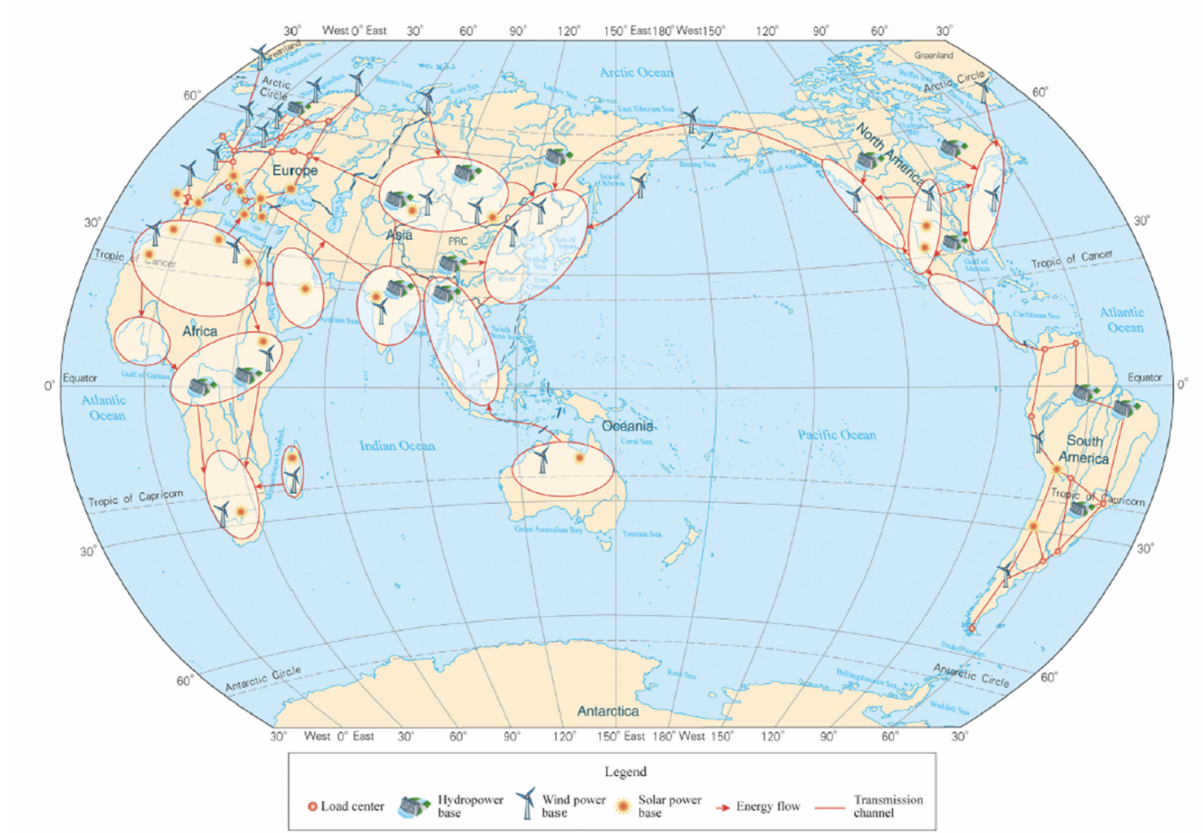
Figure 4. Backbone structure of a globally connected energy network as developed by Zhenya Liu [16], p. 211. Reproduced with permission from © China Electric Power Press